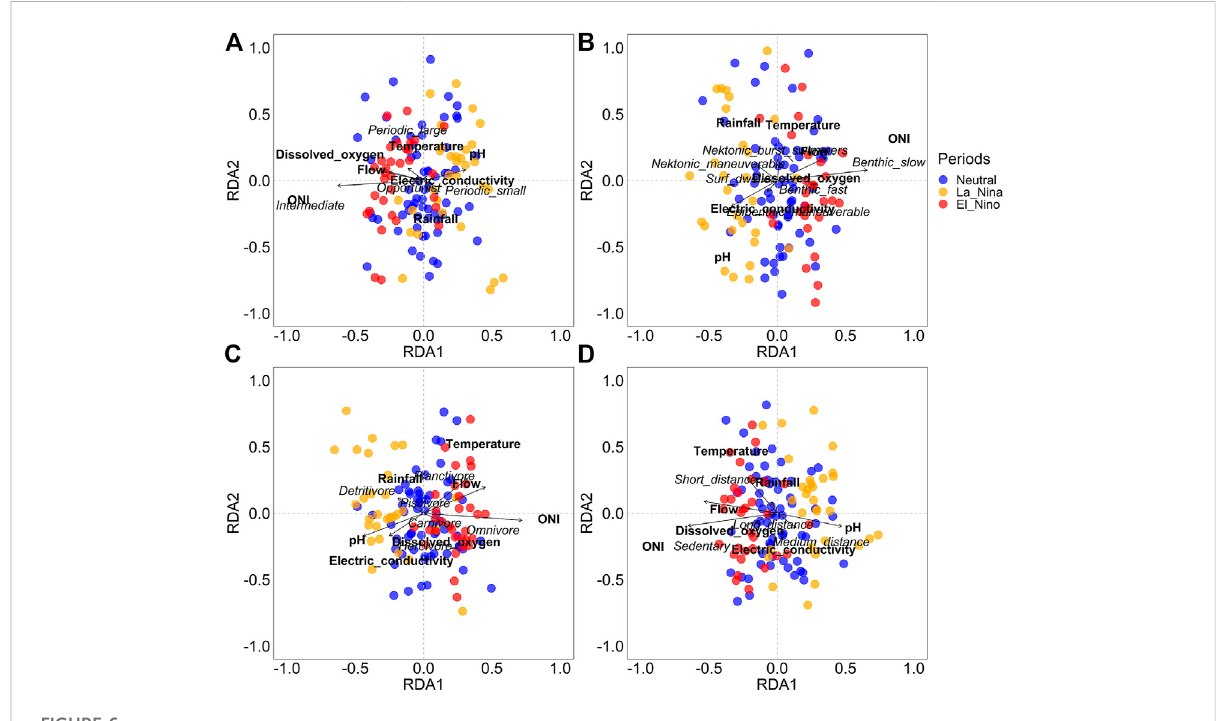
FIGURE 6 Redundancyanalysis(RDA)showingtheassociationbetweenenvironmentalvariablesandthefunctionalstructureoflarvalassemblages. (A) life history strategy, (B) feeding habits, (C) swimming/microhabitat use, and (D)